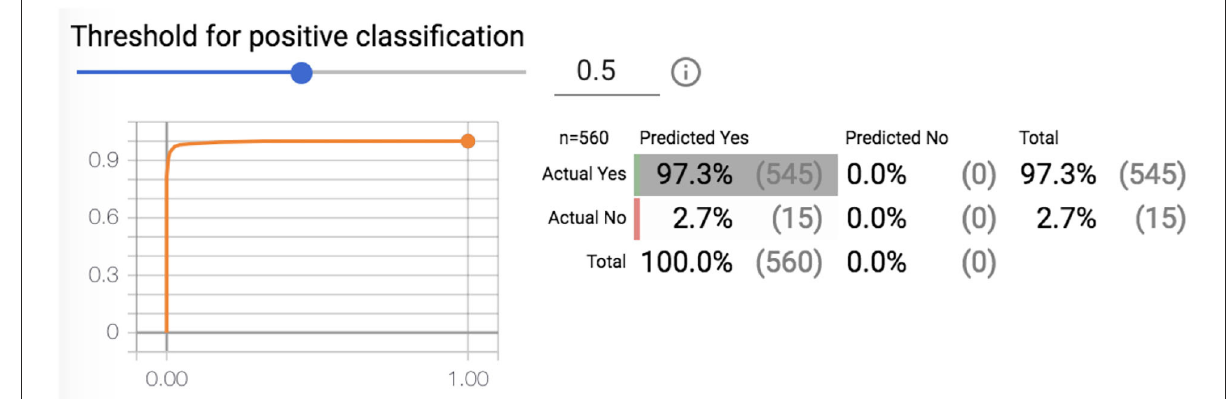
FIGURE4 Threshold for positive classification.